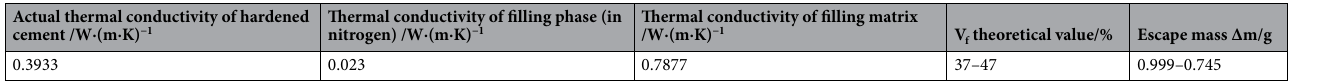
Thermal conductivity of filling phase (in nitrogen) /W·(m·K) −1